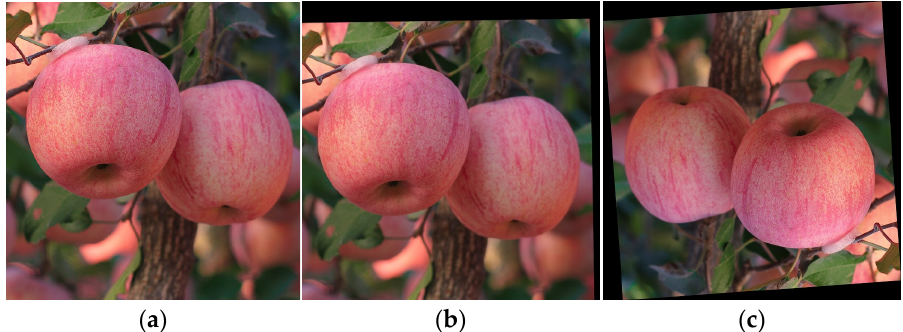
Figure 3. Augmented training data: ( a ) Original image; ( b ) random rotation + panning; and ( c ) random rotation + mirroring.